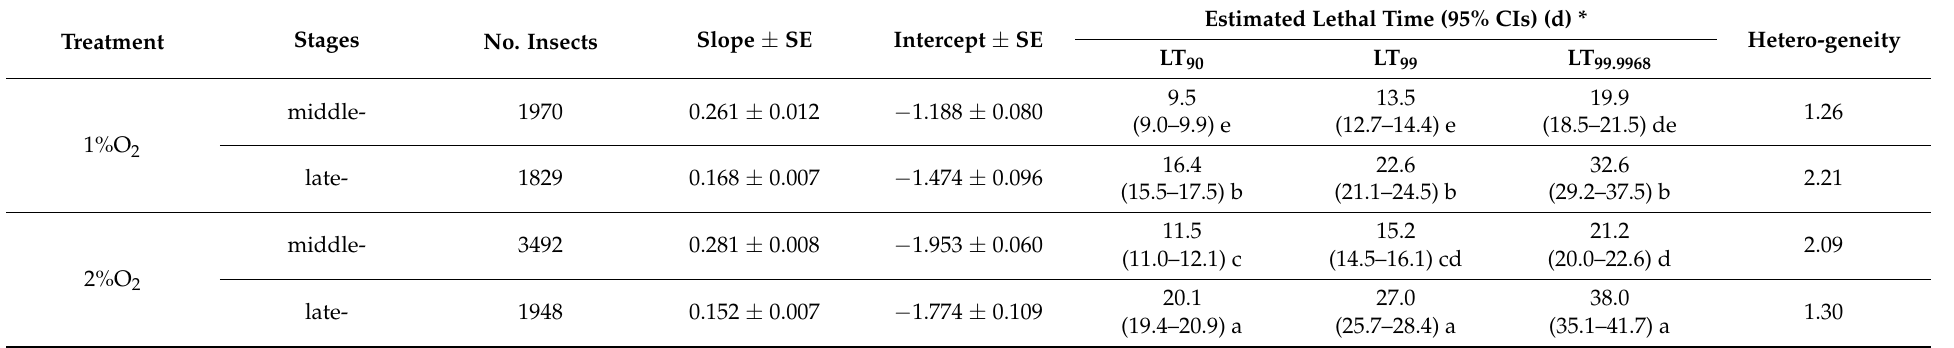
Table 3. Estimating the minimum lethal time for middle- and late-stage larvae of T. granarium treated at 24–26 °C under 1% or 2% O 2 atmosphere alone or in combination with 200 Gy X-ray